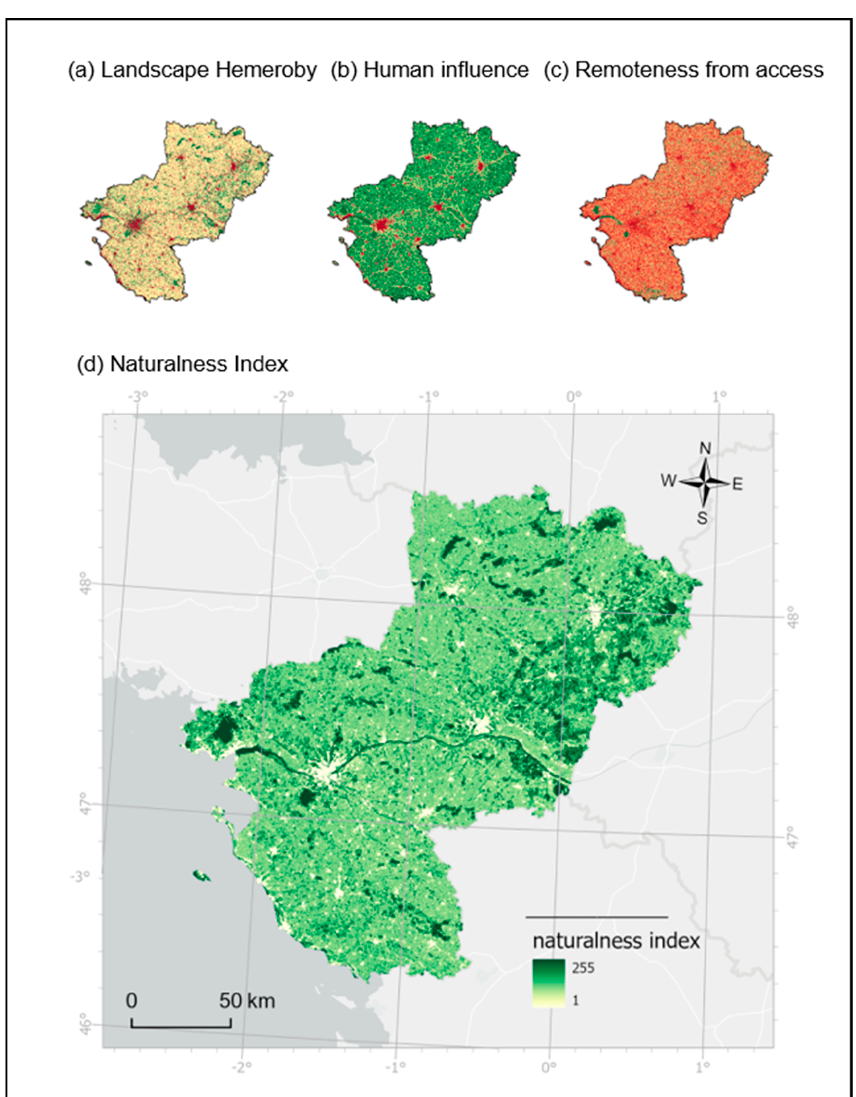
Figure 2. Maps of ( a ) landscape hemeroby; ( b ) human influence; ( c ) remoteness from access; and ( d )